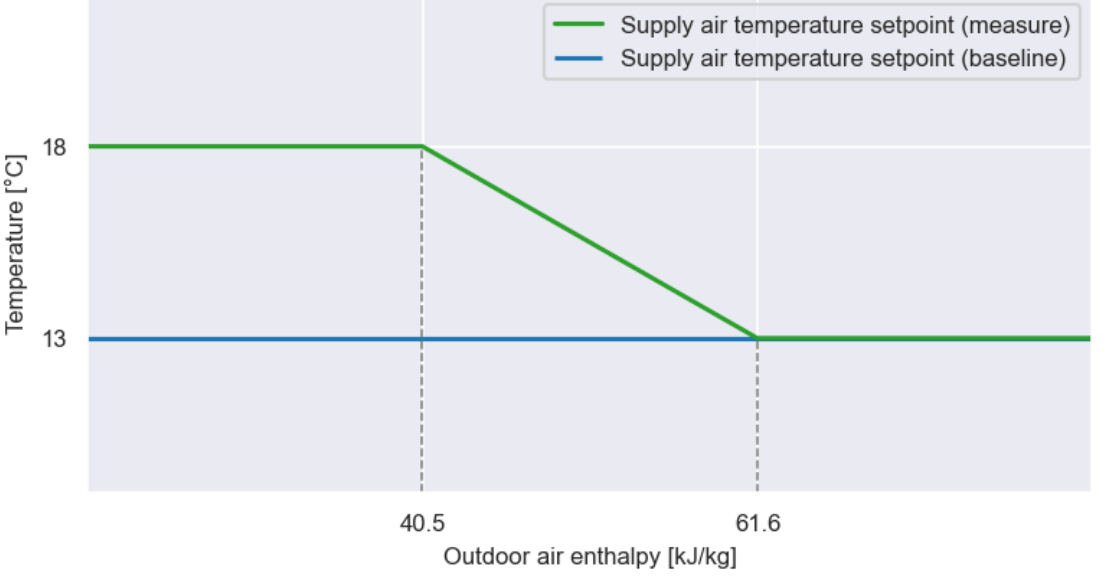
Figure 12. Proposed supply air temperature reset strategy as a function of outdoor air enthalpy while the existing supply air temperature setpoint remains constant.